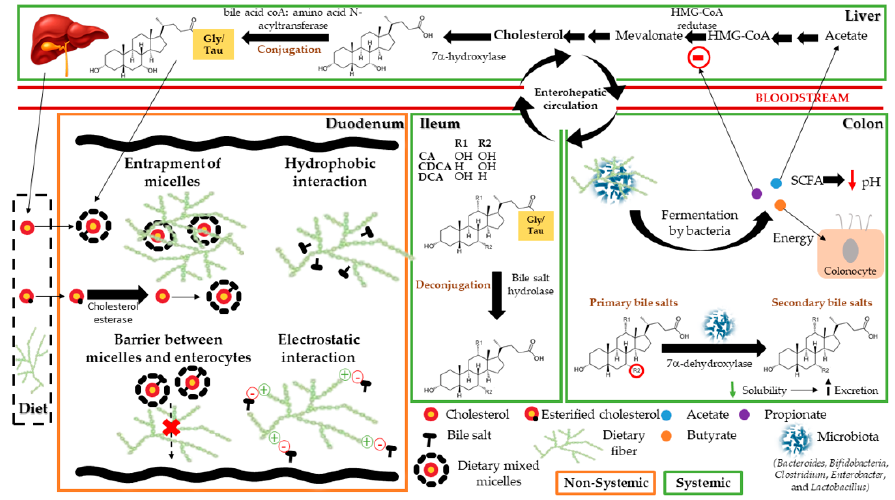
Figure 1. Schematic representation of cholesterol homeostasis steps.